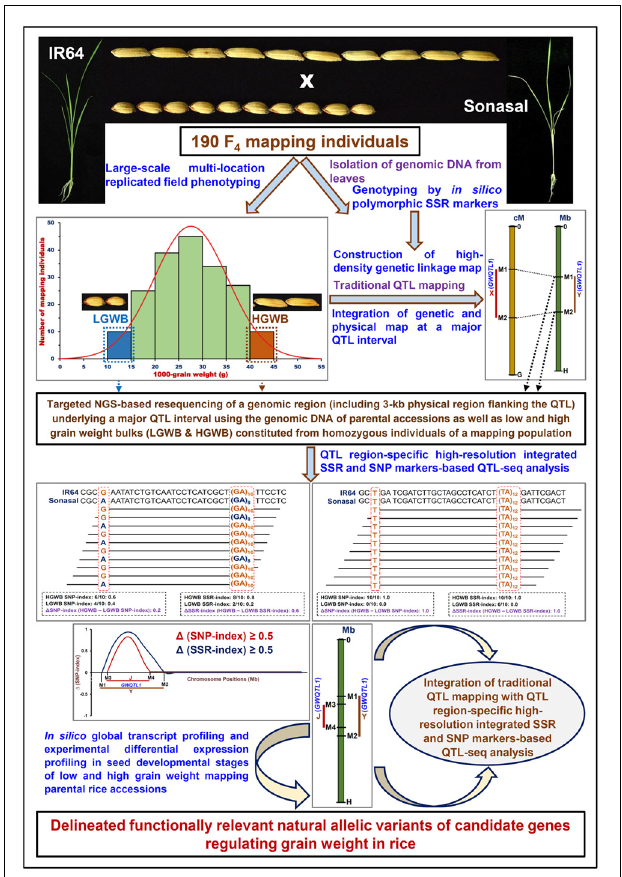
FIGURE 5 | Schematic illustrating the major steps followed to integrate traditional QTL mapping (genotyping by in silico polymorphic SSR markers) and QTL region-specific high-resolution integrated SSR and SNP marker-based QTL-seq analysis in a 190 F 4 mapping population (IR 64 × Sonasal) with differential expression profiling (during seed developmental stages of contrasting low and high grain weight mapping parental accessions) for delineating the functionally relevant natural allelic variants of candidate genes underlying a major QTL associated with grain weight in rice. LGWB, low grain weight bulk; HGWB, high grain weight